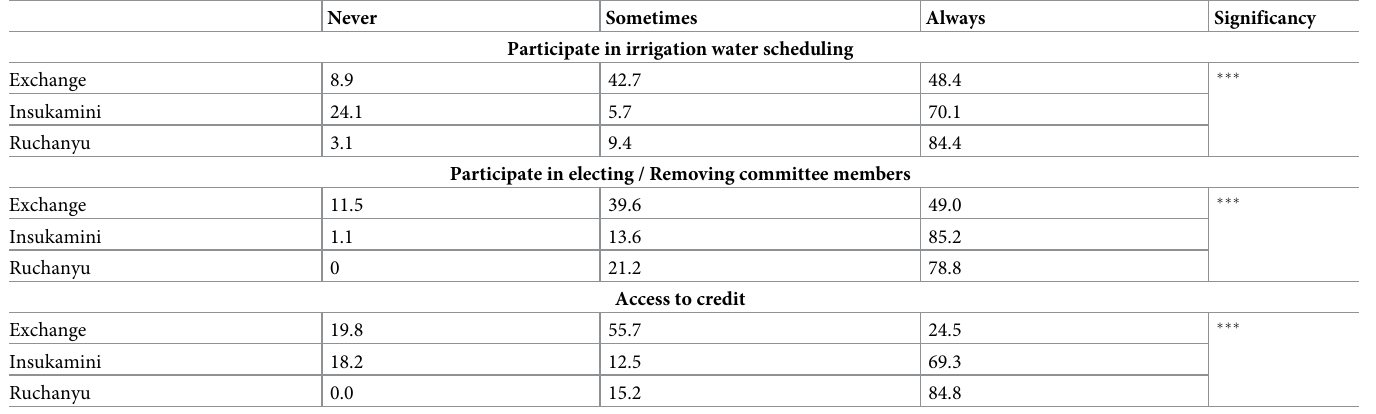
Table 5. Governance factors of Exchange, Insukamini and Ruchanyu irrigation scheme.